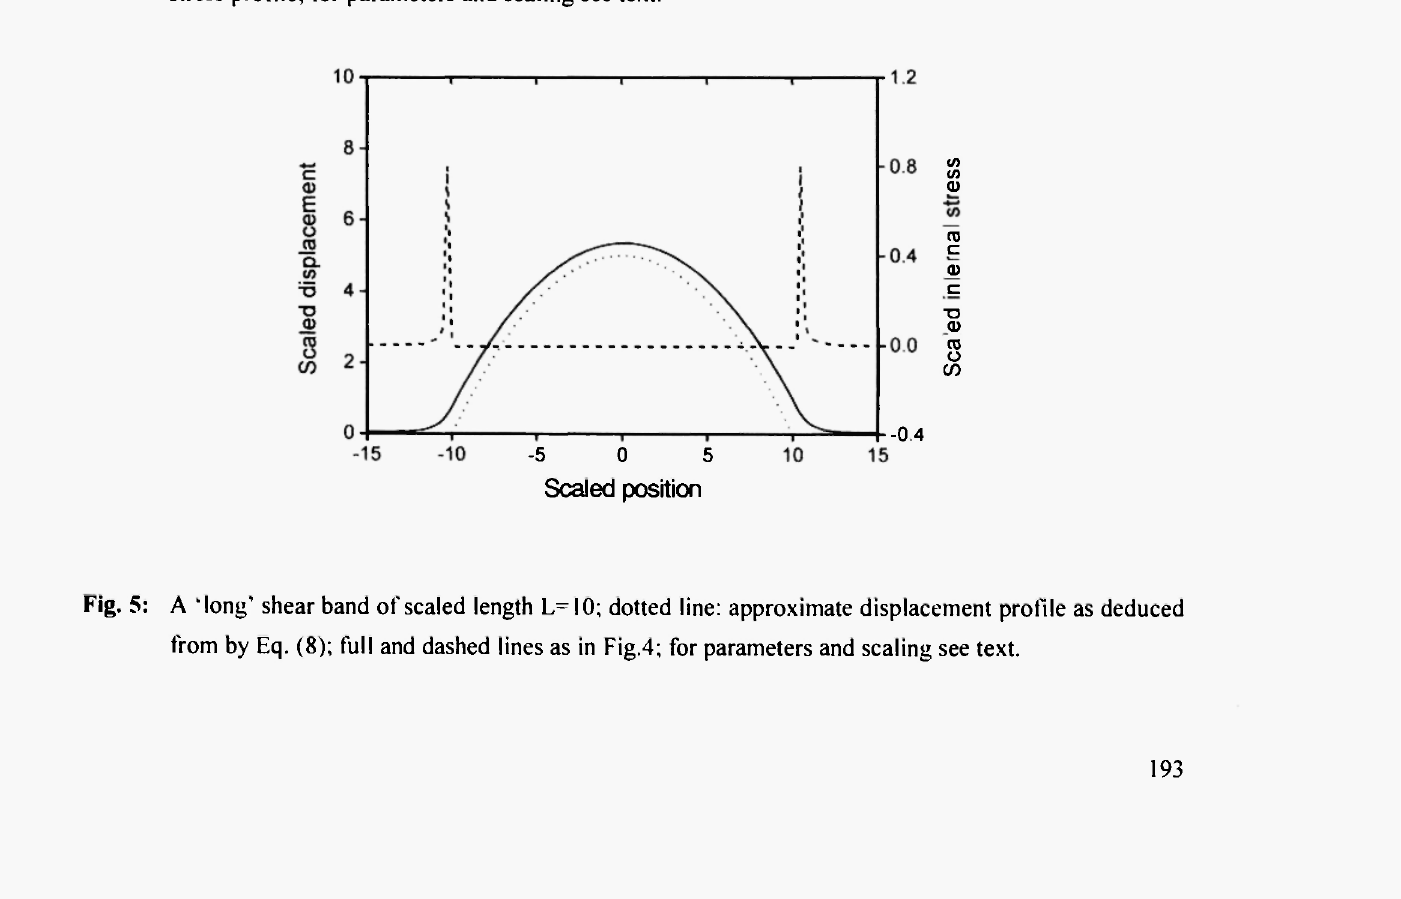
Fig. 4: A 'short' shear band of scaled length L=2.5; full line: displacement profile, dashed line: internal- stress profile; for parameters and scaling see text.